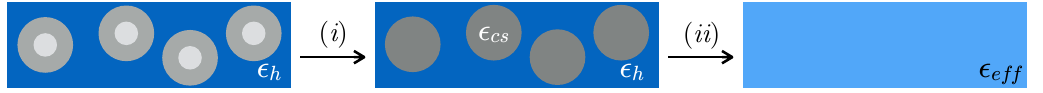
Figure 9. Procedure to reduce a system consisting on a composite core-shell type inclusion into a homogeneous